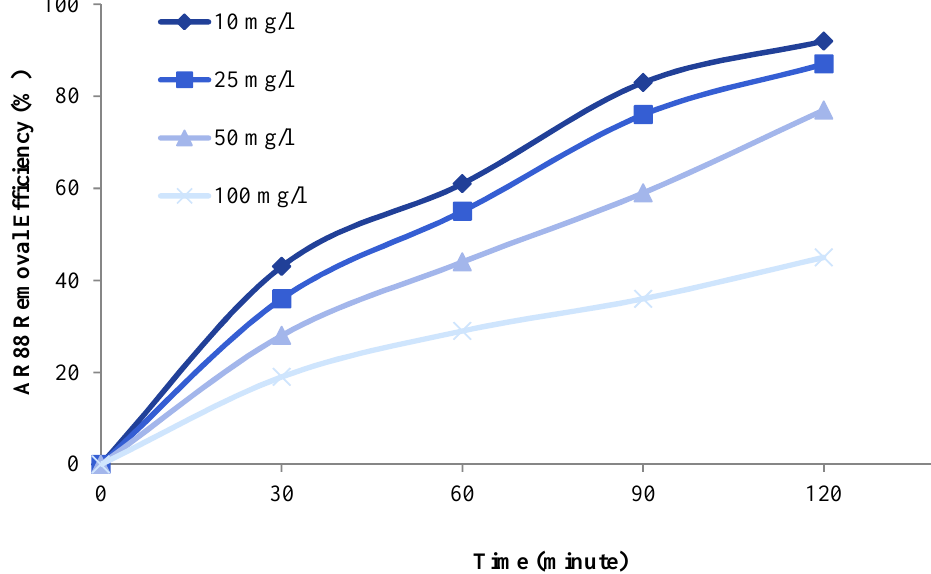
Figure 5. Effect of initial dye concentration on the photocatalytic removal of Acid Red 88 (AR88) from aqueous solutions (pH: 7, time: 120